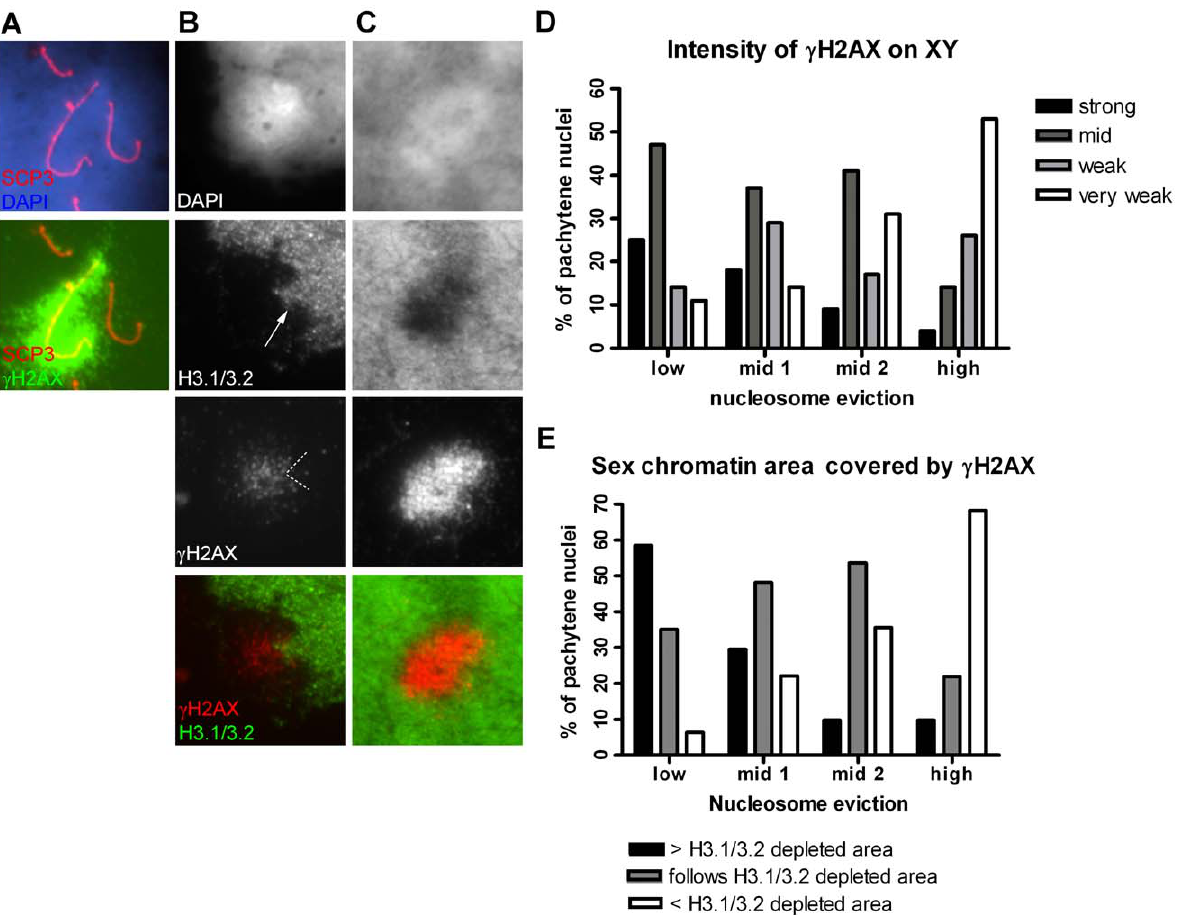
Figure 3. c H2AX in early and late pachytene XY bodies. A Early pachytene nucleus. The complete X and Y chromatin is covered by c H2AX. B Late pachytene XY body with a high degree of H3.1/3.2 nucleosome remodelling and a decreased c H2AX signal (very weak, , H3.1/3.2 depleted area). A clear bulge of H3.1/3.2 signal is present (arrow) with almost no overlaying c H2AX signal. H3.1/3.2 bulge indicated by the dotted lines. C Late pachytene XY body with a low degree of H3.1/3.2 nucleosome remodelling and a strong c H2AX signal ( . H3.1/3.2 depleted area). D Histogram displaying the relation between the degree of H3.1/3.2 nucleosome remodelling and the intensity of the c H2AX signal, classified into four categories (bars) (n=203, P1-3, C3). E Histogram displaying the relation between the degree of H3.1/3.2 nucleosome remodelling and the area of XY chromatin covered by c H2AX, classified into four categories (bars) (n=203, P1-3, C3).